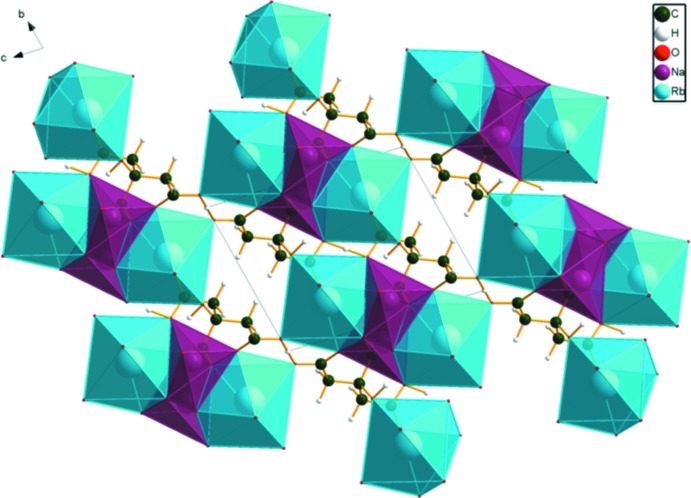
Crystal structure of NaRbHC6H5O7, viewed down the a axis.